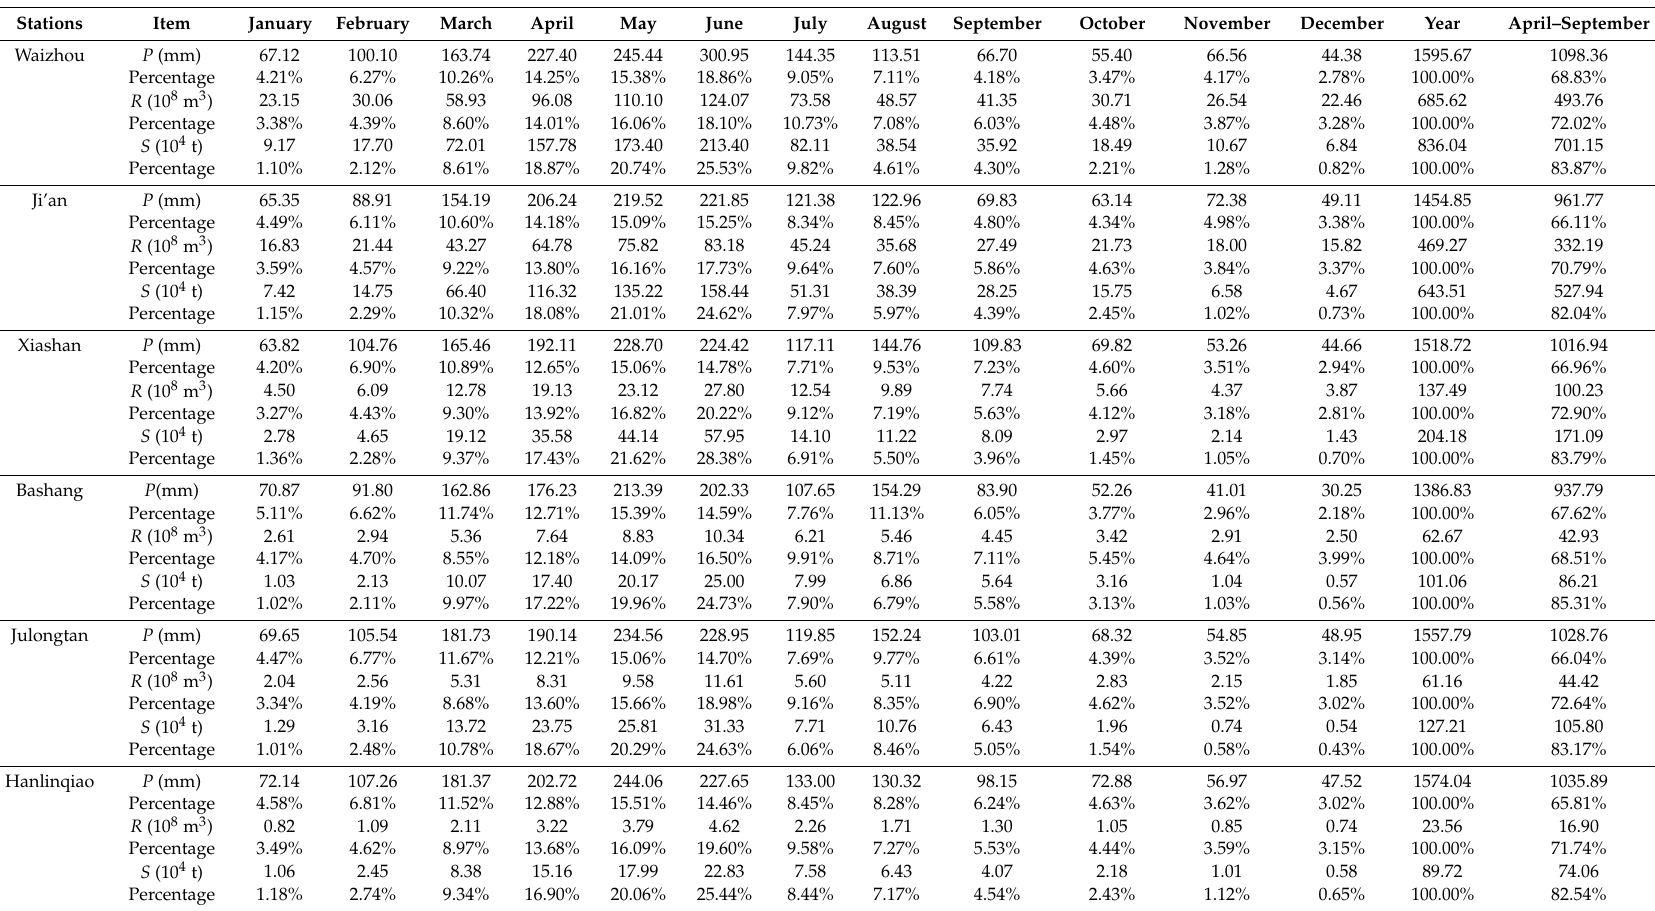
Table 2. Monthly mean precipitation (P), streamflow (R), and sediment discharge (S) in the Gangjiang River basin and percentage of annual amount.